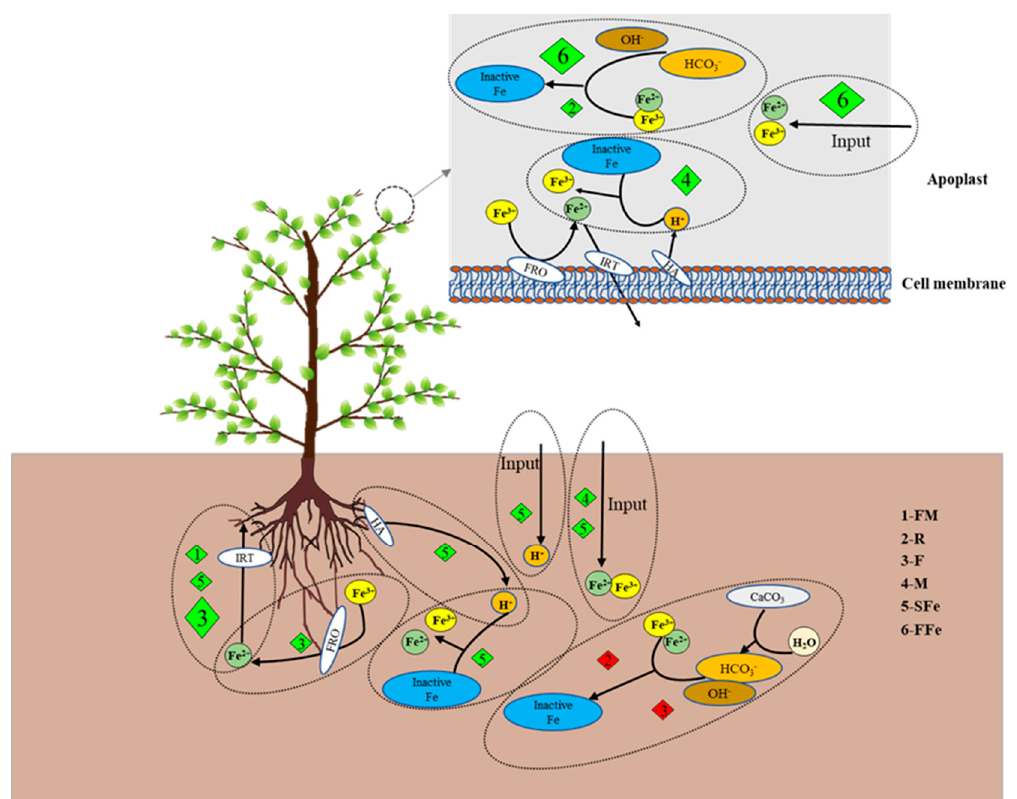
Figure 7. Model of how different practices alleviate Fe deficiency in pear trees in calcareous soil. The black arrow represents the direction of the process. The steps inside the dotted ovals represent a complete process. The diamonds with different numbers represent the different practices. The practices shown within a dotted oval will affect the corresponding process. The size of the diamond represents the magnitude of the impact of the corresponding practice. Green diamonds represent positive effects, and red diamonds represent negative effects. FM: flattening with landscape fabric mulching, R: ridging without landscape fabric mulching; F: flattening without landscape fabric mulching; M: Manure application; SFe: Fe application in soil; FFe: Foliar Fe application.